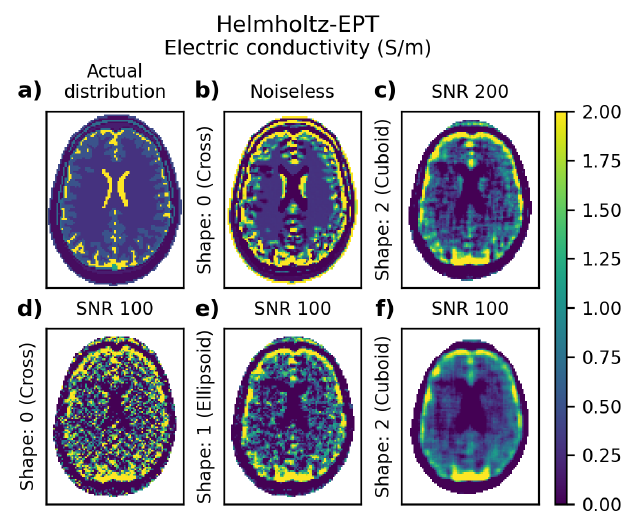
Figure 6. Electric conductivity distributions recovered by complete Helmholtz-EPT. ( a ) Actual distribution at 64MHz in the considered section. ( b ) Distribution recovered from noiseless input with a cross window of size [1,1,1] for the Savitzky–Golay filter. ( c ) Distribution recovered from input with SNR 200 using a cubic window of size [2,2,2] for the Savitzky–Golay filter. ( d – f ) Distributions recovered from input with SNR 100 using windows of size [3,3,3] and different shapes (cross, ellipsoid and cuboid, respectively) for the Savitzky–Golay